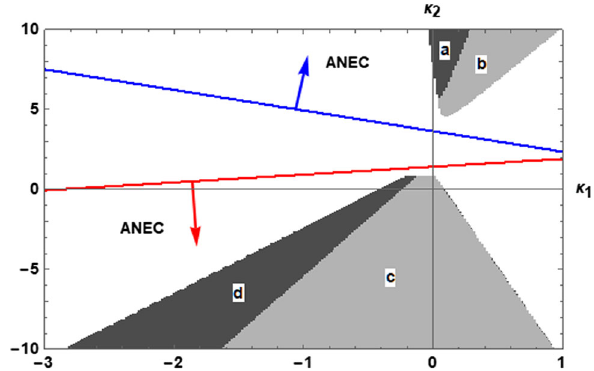
Fig. 3 Holographic RG flow in the example 1